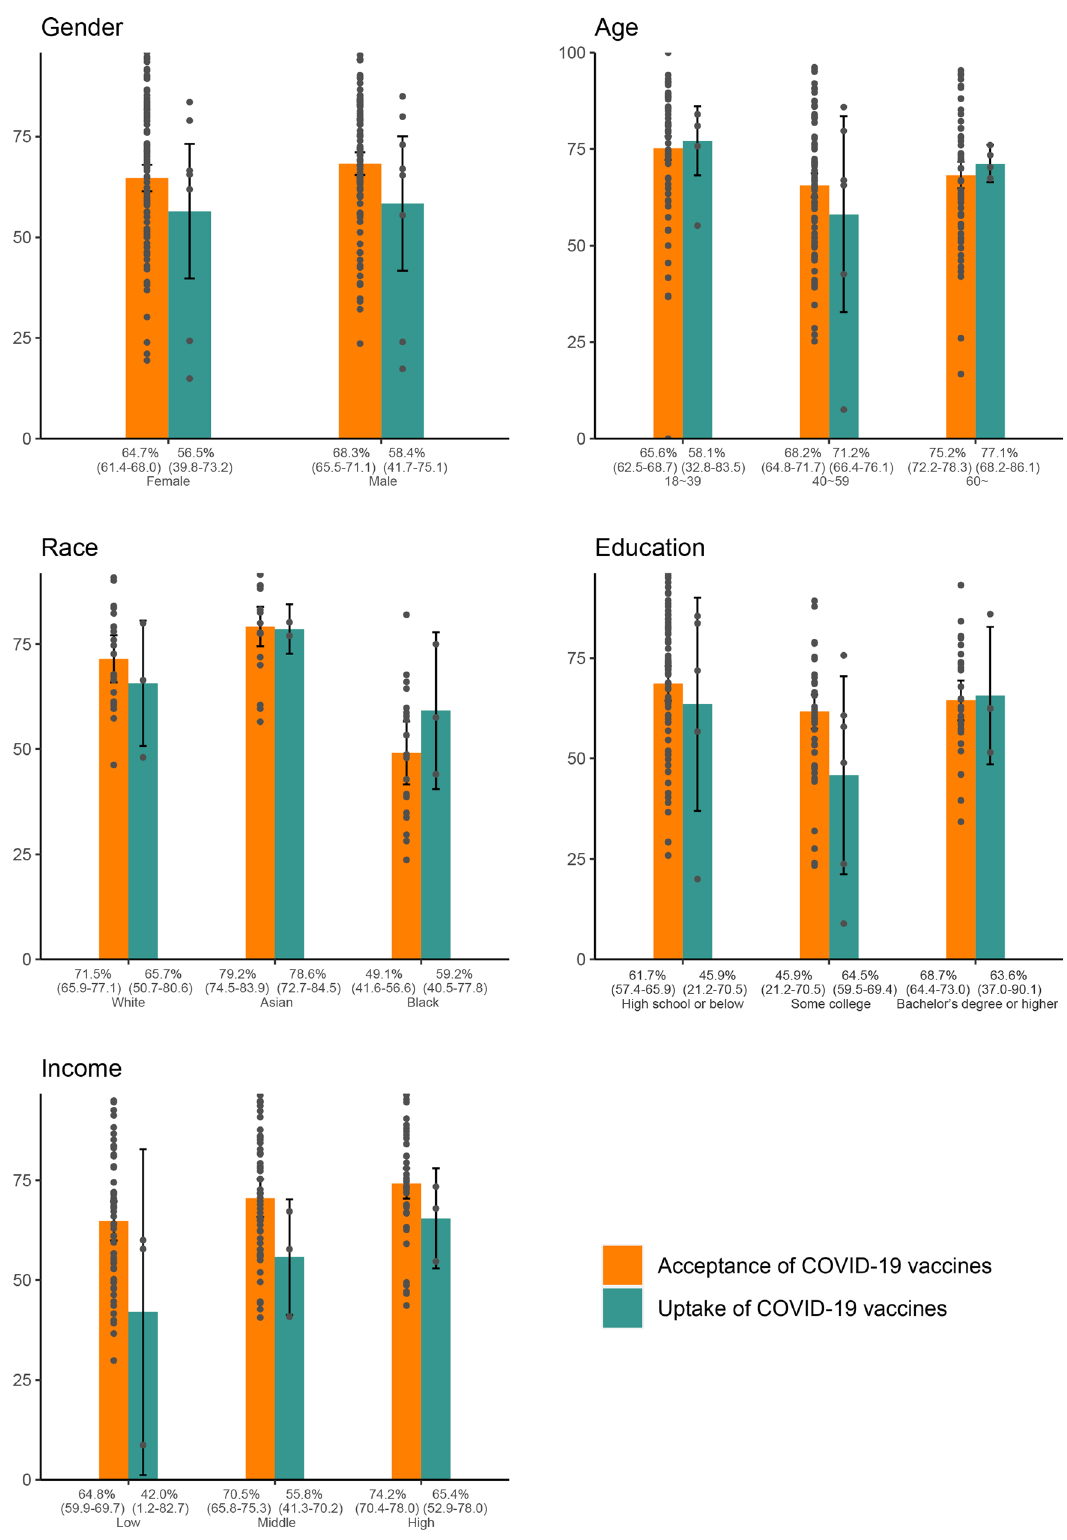
Fig. 5 COVID-19 vaccination acceptance and uptake rates by subgroups for adults. Estimated acceptance (orange block) and uptake (green block) rates and 95% con fi dence interval (CI) of COVID-19 vaccination by subgroups for adults are shown. The subgroups include gender ( n = 819,147 participants), age ( n = 522,343 participants), race ( n = 51,286 participants), education ( n = 269,342 participants), and income ( n = 298,195